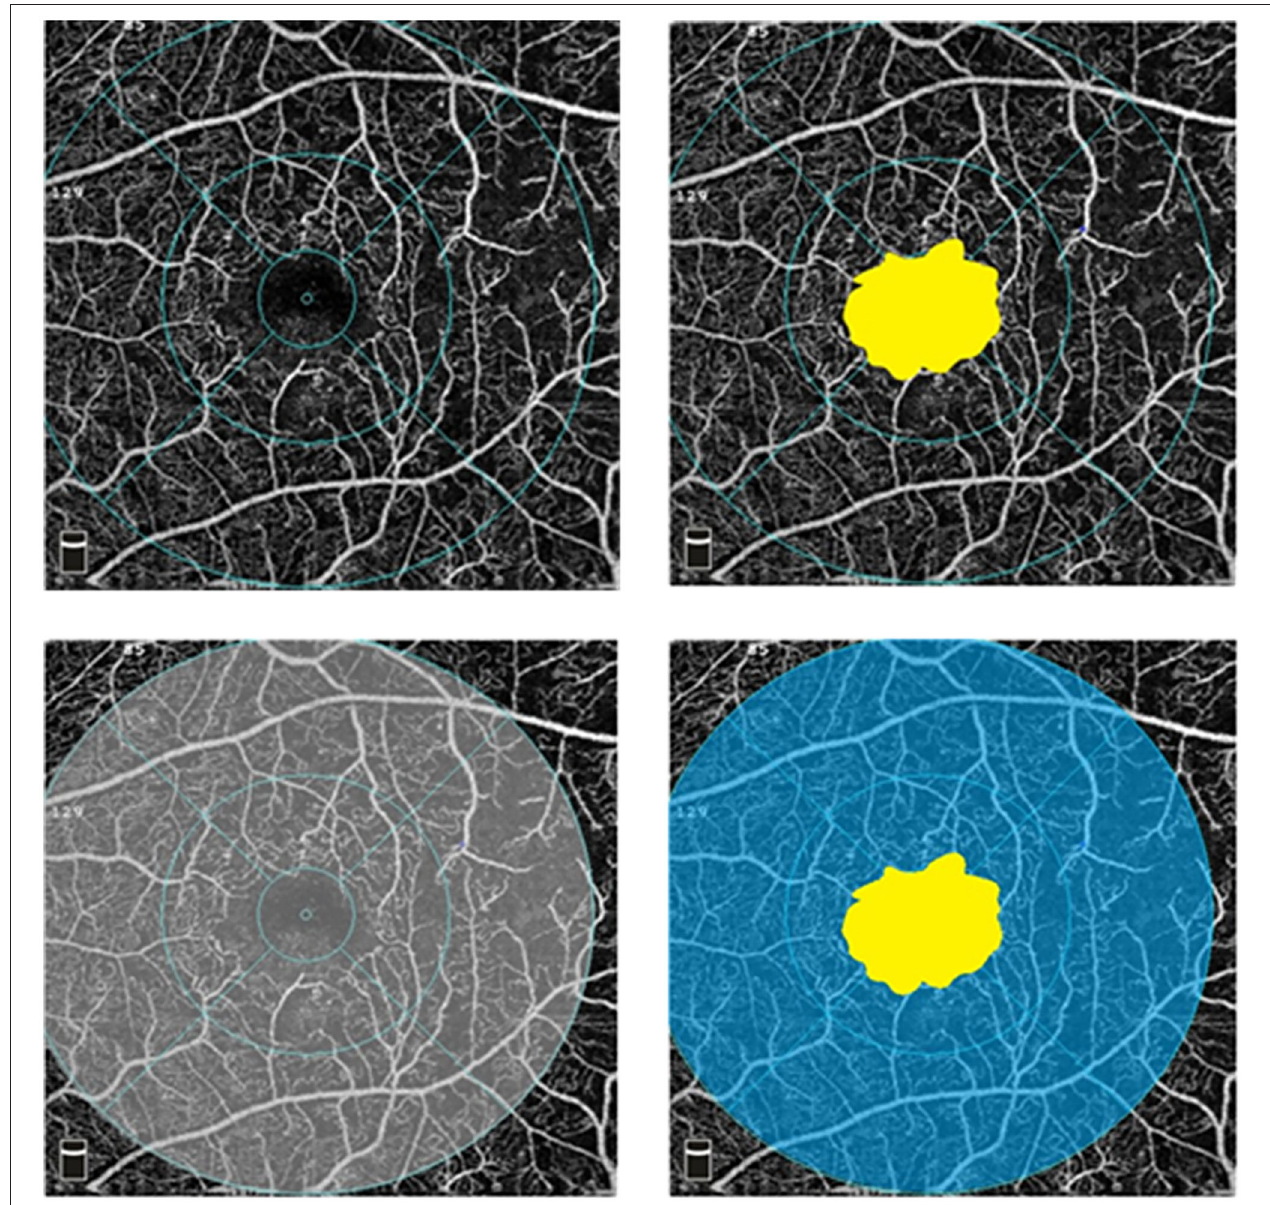
FIGURE 1 | Optical coherence tomography angiography (OCTA) images in superficial capillary plexus (6 × 6mm). The foveal avascular zone (FAZ) area measurement is located in the yellow area, vessel density (VD) measurement is located in the gray area, and ischemic index (ISI) measurement is located in the blue area.